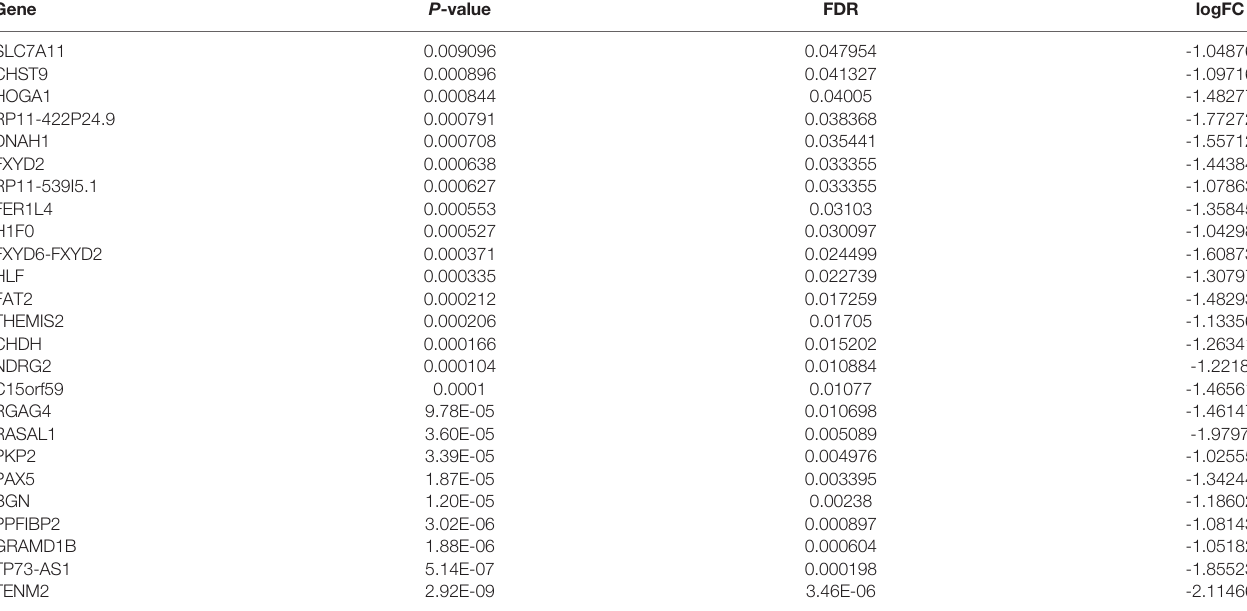
TABLE 2 | A total of 25 genes were found to be downregulated in TPC-1-Lv-FTO and vector cell lines by RNA-seq sequencing [logFC <-1, p < 0.05, false discovery rate (FDR) <0.05]. Gene P -value FDR